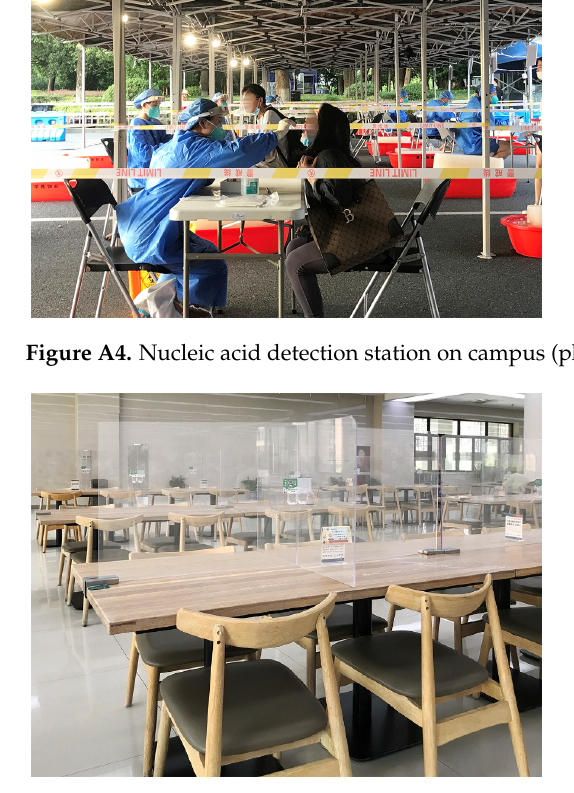
Figure A5. Transparent panels on dining tables to prevent infection (photo taken on 2 September 2022).